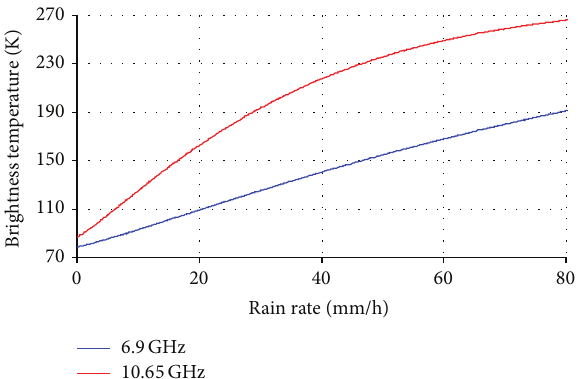
Figure 1: Simulated horizontally polarized brightness temperature as a function of rain rate for 6.9 GHz (upper curve) and for 10.65 GHz (lower curve). All the other meteorological and hydro- logical parameters are fixed. Total atmospheric water vapor content is 26 kg/m 2 , total cloud liquid water content is 0.26 kg/m 2 , rain layer thickness is 1.35 km, sea surface wind speed is 5 m/s, and sea surface temperature is 10 ∘